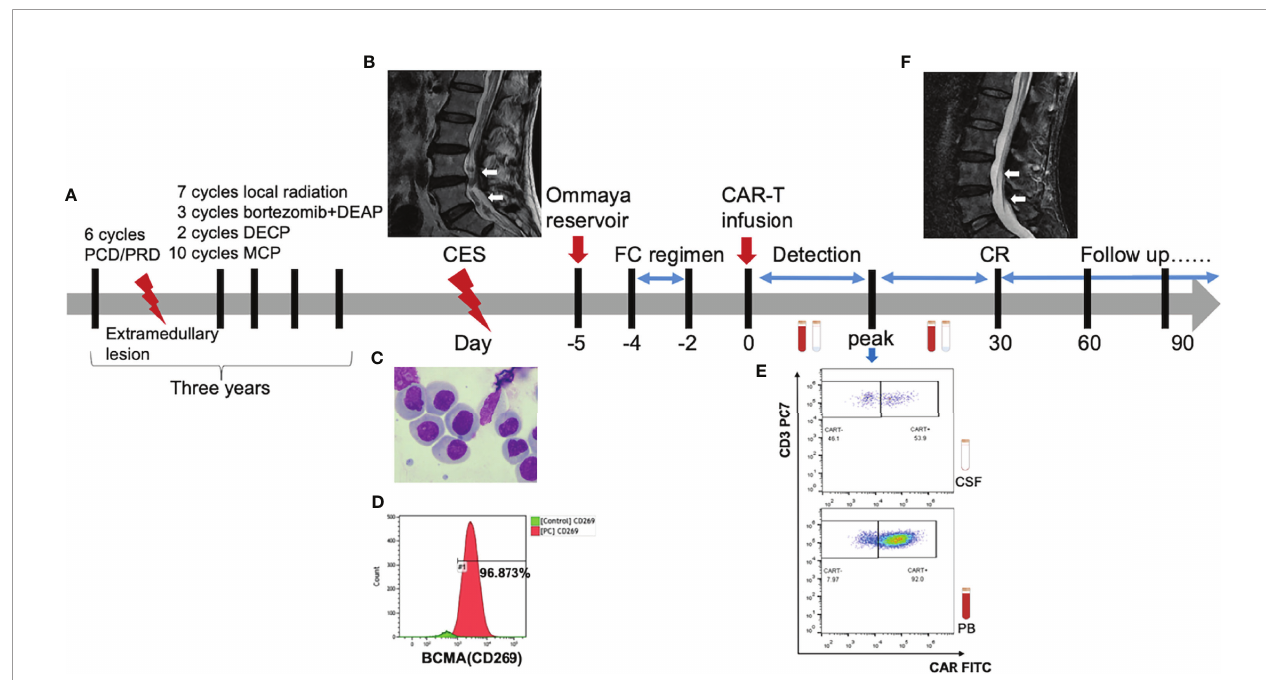
FIGURE 2 | (A) The fl owchart of patient ’ s treatment history and CAR-T therapy. (B) Pretreatment lumbar MRI showed multiple diffuse abnormal signal nods in the cauda equina at lumbar and caudal level. (F) The lesion disappeared in the post-treatment imaging, indicating a complete remission (CR) [high-resolution T2- weighted image]. (C) Abnormal plasma cells were observed under the microscope. There were 300 nucleated cells/ m L in the cerebrospinal fl uid of which 35% were plasmablast and 54% were proplasmacyte. (D) The fl ow cytometry indicated that 96.873% of the plasma cells were expressed with BCMA antigens. (E) The CAR-T cells peaked 53.9% in CSF at day 8 and 92.0% in PB at day